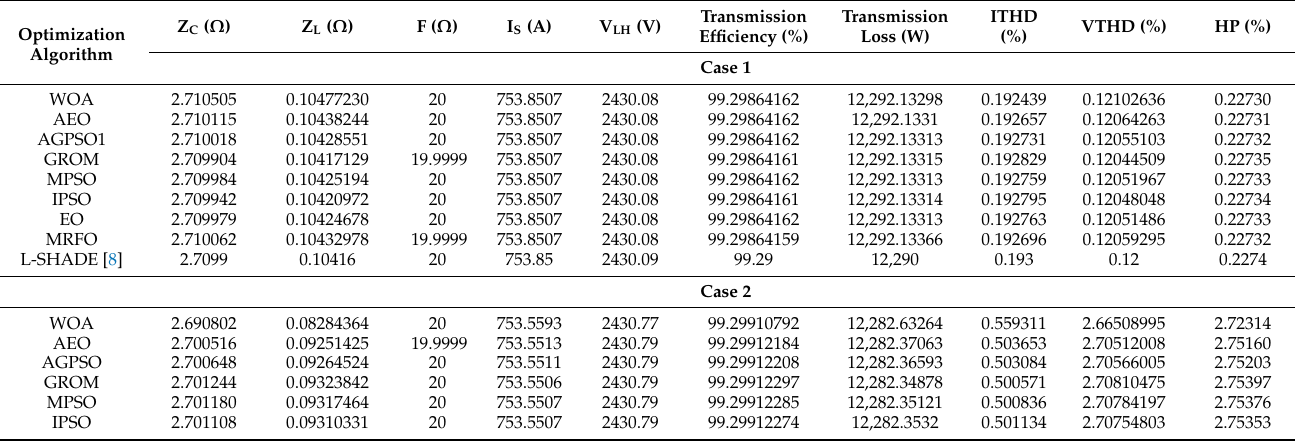
Table 5. The results of optimization algorithms for configuration 2 of HAPF system over the three different